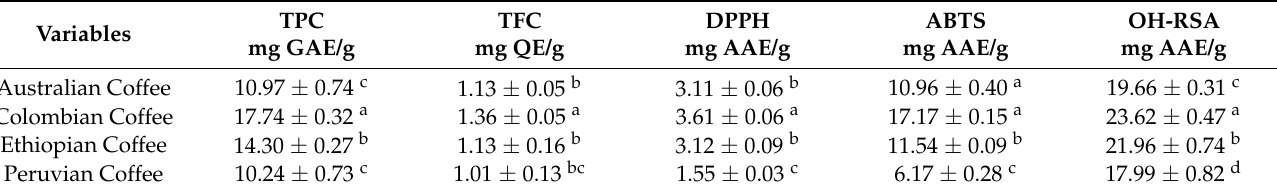
Table 1. Quantification of phenolic contents and their antioxidant